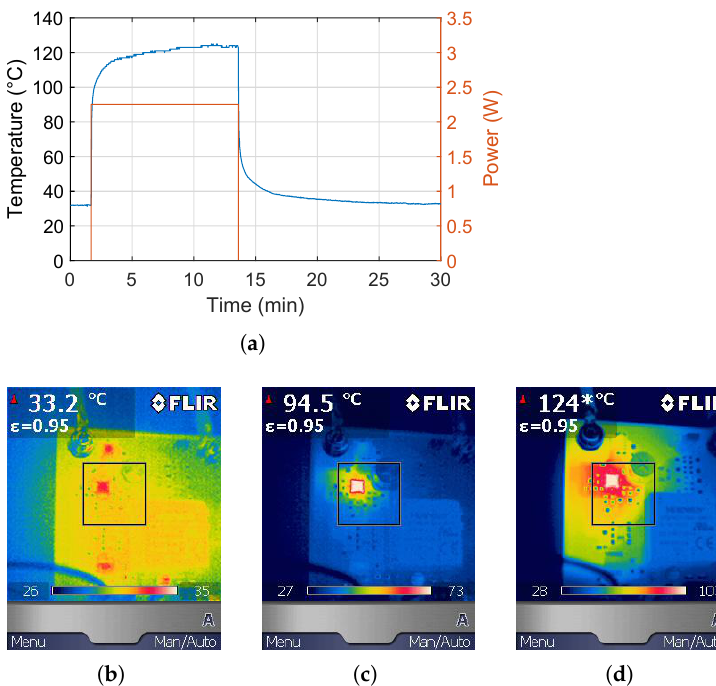
Figure 6. OPA567 temperature, measured with a FLIR i50 infrared camera, during the worst case test in which the amplifier dissipates 2.25W for about 12min ( a ). Camera screenshots acquired before ( b ), after 10s ( c ), and after 10min ( d ) from the application of the power